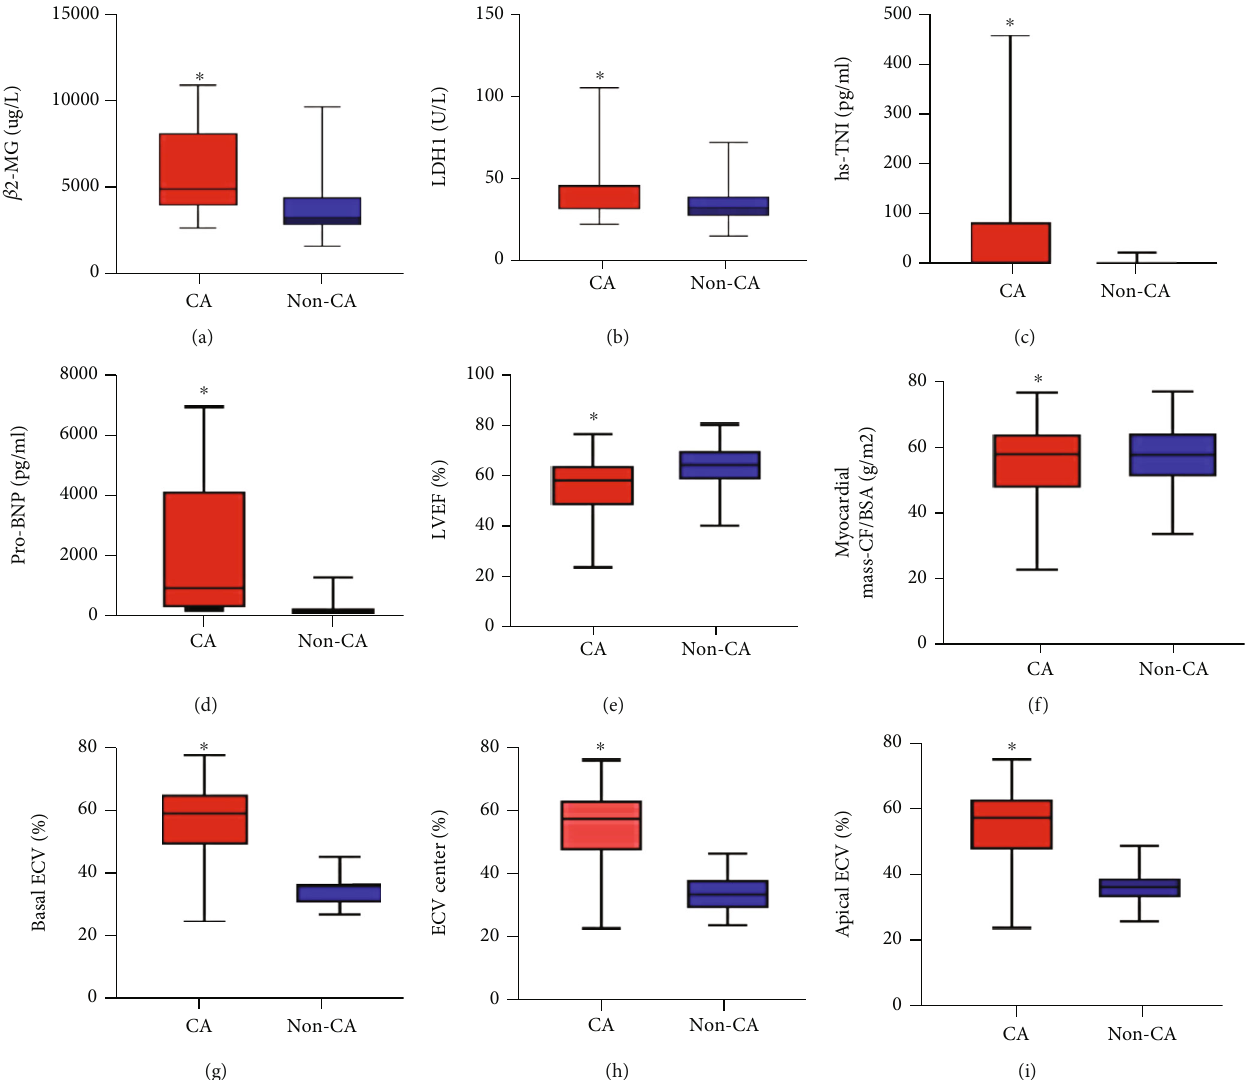
Figure 2: The comparison of biochemical parameters between patients with or without CA. (a) β 2-microglobulin ( β 2-MG) (CA, n = 19 ; non-CA, n = 32 ). (b) Lactate dehydrogenase 1 (LDH1) (CA, n = 19 ; non-CA, n = 32 ). (c) High-Sensitivity Troponin I (hs-TNI) (CA, n = 19 ; non-CA, n = 32 ). (d) Pro-brain natural peptide (pro-BNP) (CA, n = 19 ; non-CA, n = 32 ). (e) Left ventricular ejection fraction (LVEF) (CA, n = 19 ; non-CA, n = 32 ). (f) Myocardial mass (CF/BAS) (CA, n = 19 ; non-CA, n = 32 ). (g) Basal ECV (CA, n = 19 ; non-CA, n = 32 ). (h) Mid ECV (CA, n = 19 ; non-CA, n = 32 ). (i) Apical ECV (CA, n = 19 ; non-CA, n = 32